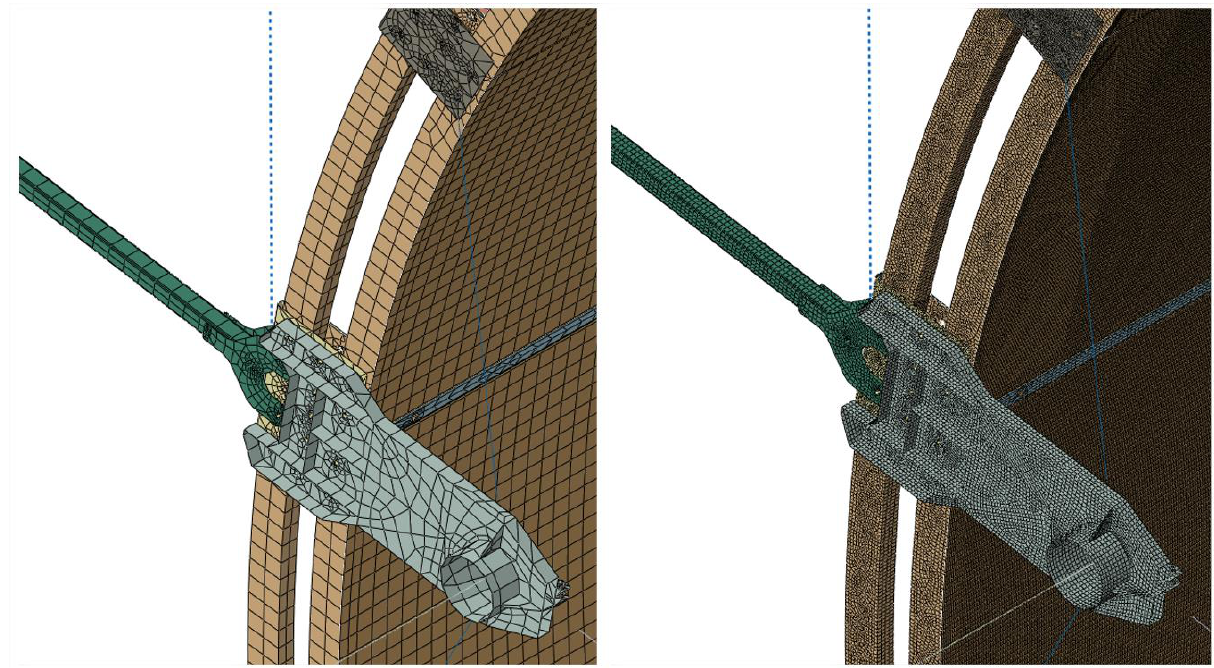
Figure 2. Examples of different mesh sizes: coarse on the left, refined on the right.